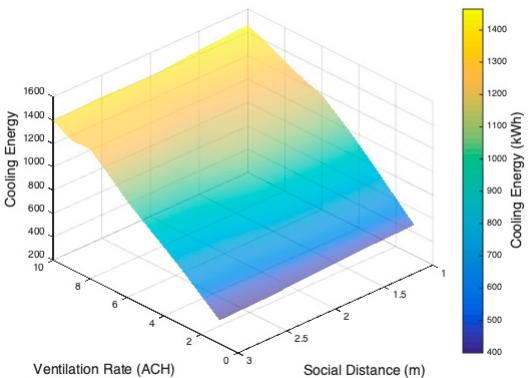
Figure 10. Impacts of MV ventilation rate and social distance on the cooling energy use for July 22 nd .